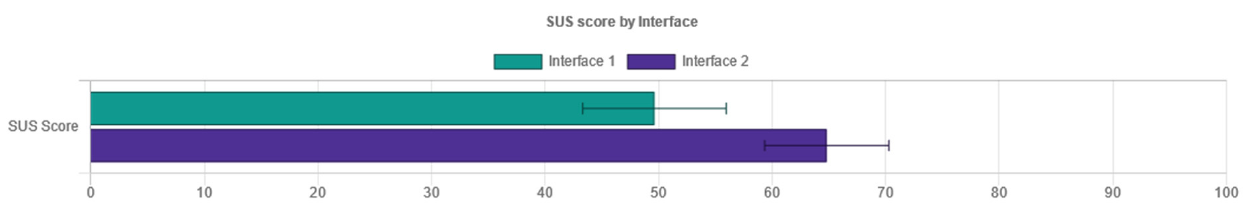
Figure 10. UEQ dimensions by interface. The NASA-Task Load Index by each interface presented no statistically significant differences in almost on all task load dimensions except for self-assessed performance and frustration. NASA-TLX implied slightly lower user’s self-assessed performance and effort in the FCD-based interface (Figure 11).